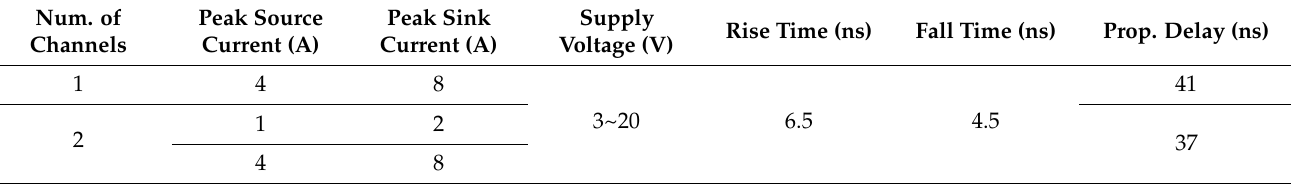
Table 20. Commercial GaN HEMT drivers by Infineon Technologies.